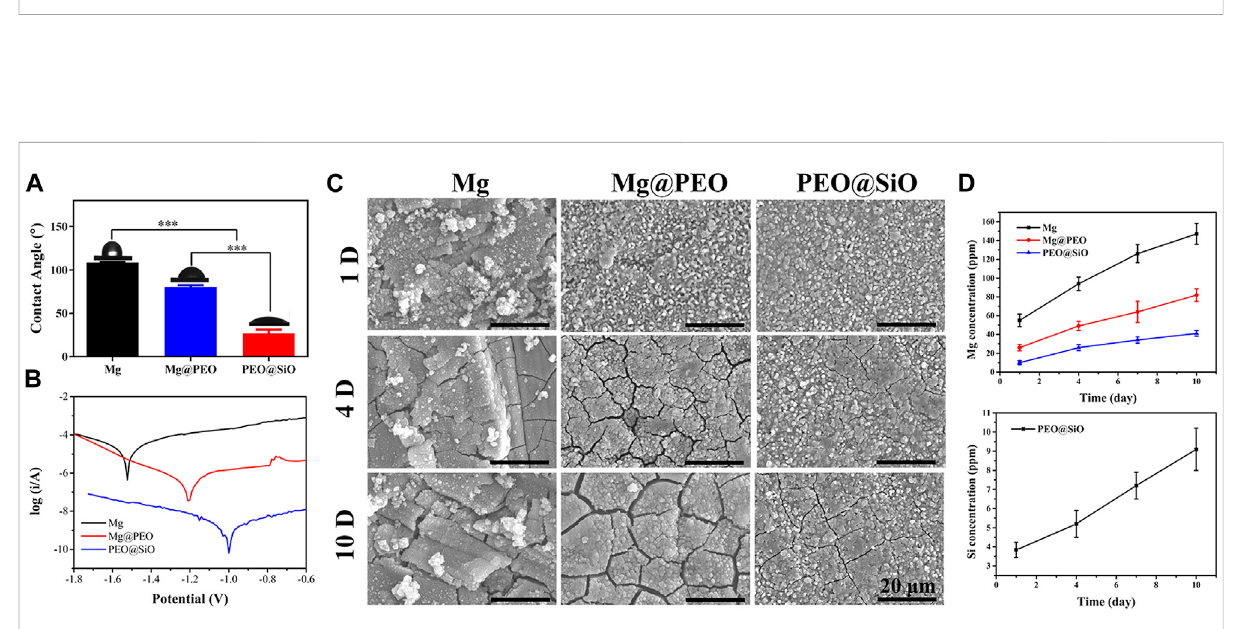
FIGURE 2 (A) XRD patterns of the Mg, Mg@PEO, and PEO@SiO samples. (B) Full XPS spectra of the Mg@PEO and PEO@SiO samples. (C) High-resolution spectrum of Si 2p for the PEO@SiO sample.